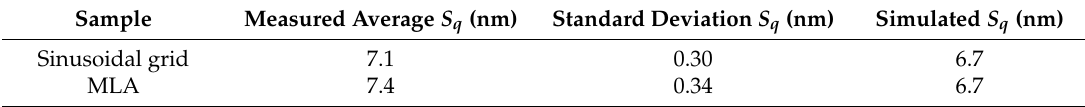
Figure 23. Topography distribution of MLA surface. Table 5. Surface topography S q by actual measurement and simulation.